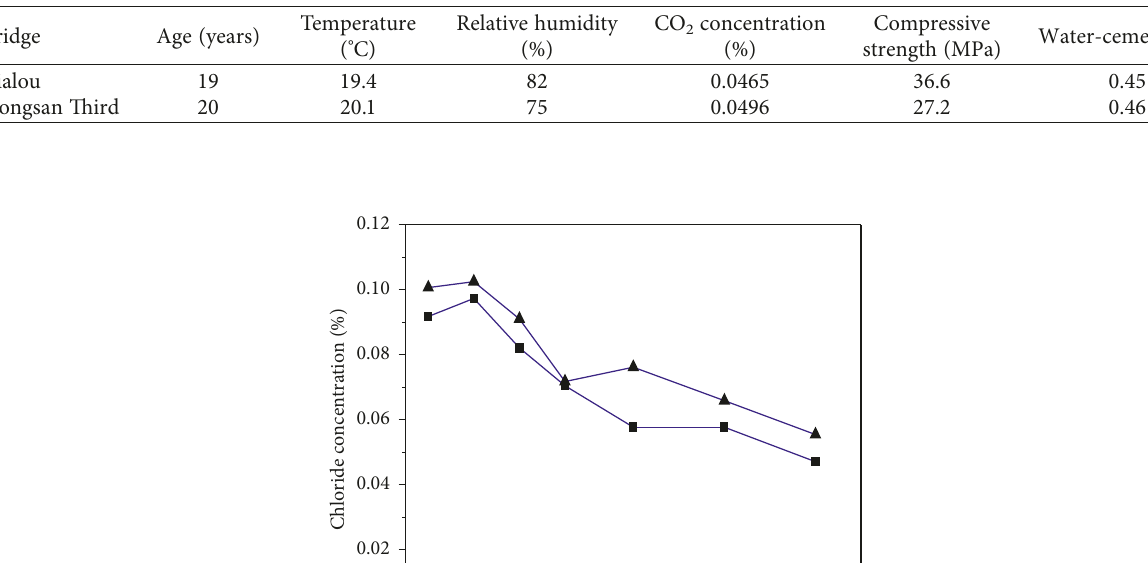
Table 10: Field condition of Xialou bridge and Hongsan Third bridge.